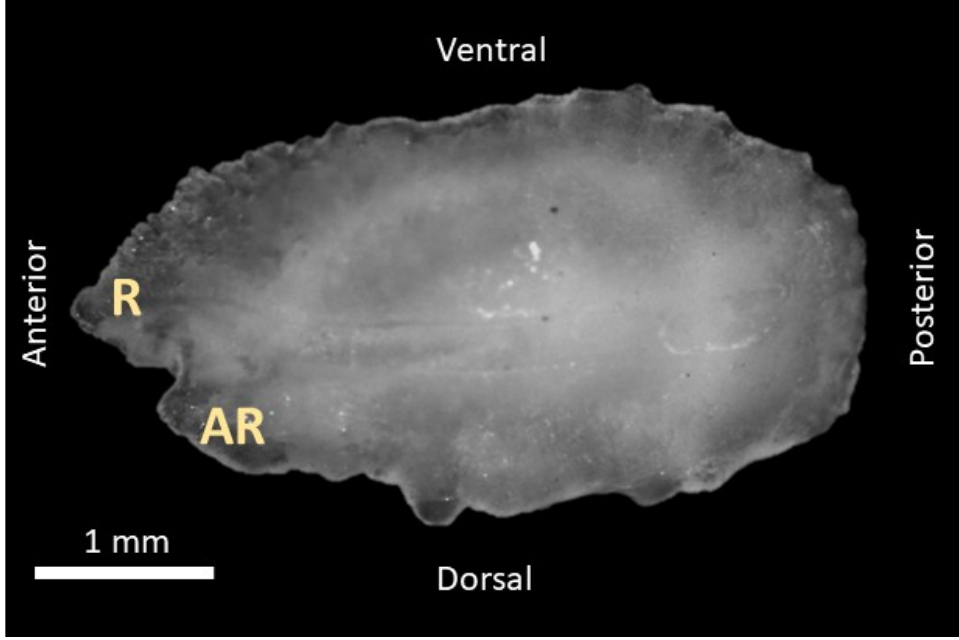
Figure 2. Left sagitta otolith of Odontesthes argentinensis . Features variables. AR: Anti rostrum. R: Rostrum.